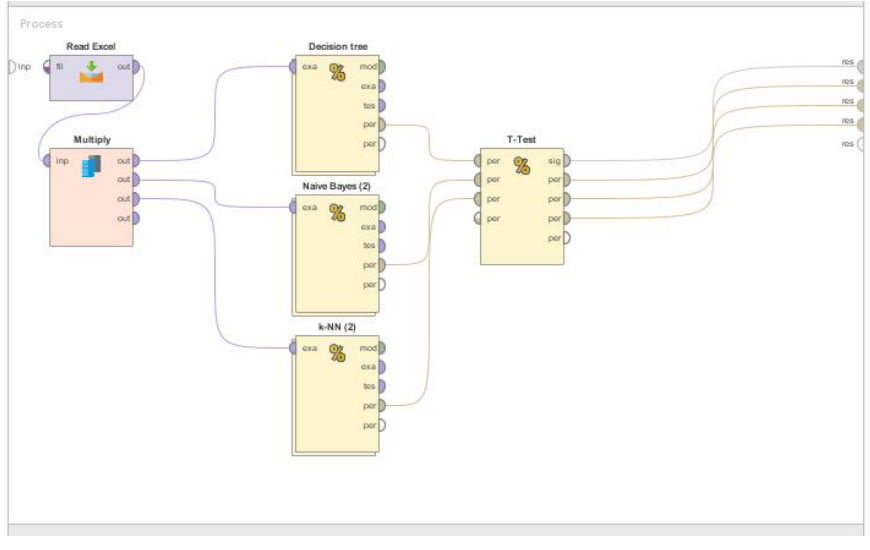
Fig. 7. Testing Model Design